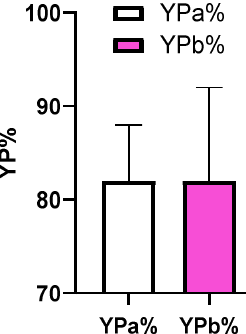
Figure 3. Yields of production for aRB-PCL (YPa%) and bRB-PCL (YPb%).